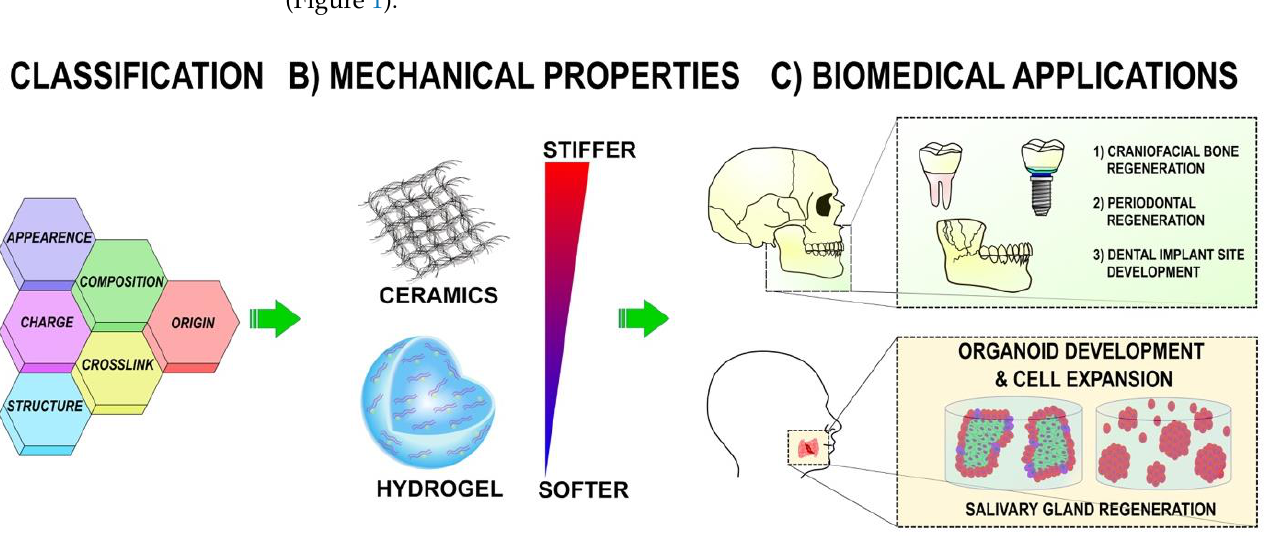
Figure 1. Polymeric Scaffolds for Dental, Oral and Craniofacial Regeneration. ( A ) Polymeric scaffolds can be classified according to their appearance, charge, structure, composition, crosslinking and origin. ( B ) Polymeric scaffolds have a wide range of mechanical properties that can be tuned to affect cellular behavior. ( C ) Polymeric scaffolds have various applications in tissue engineering in the context of dental, oral, and craniofacial regeneration.